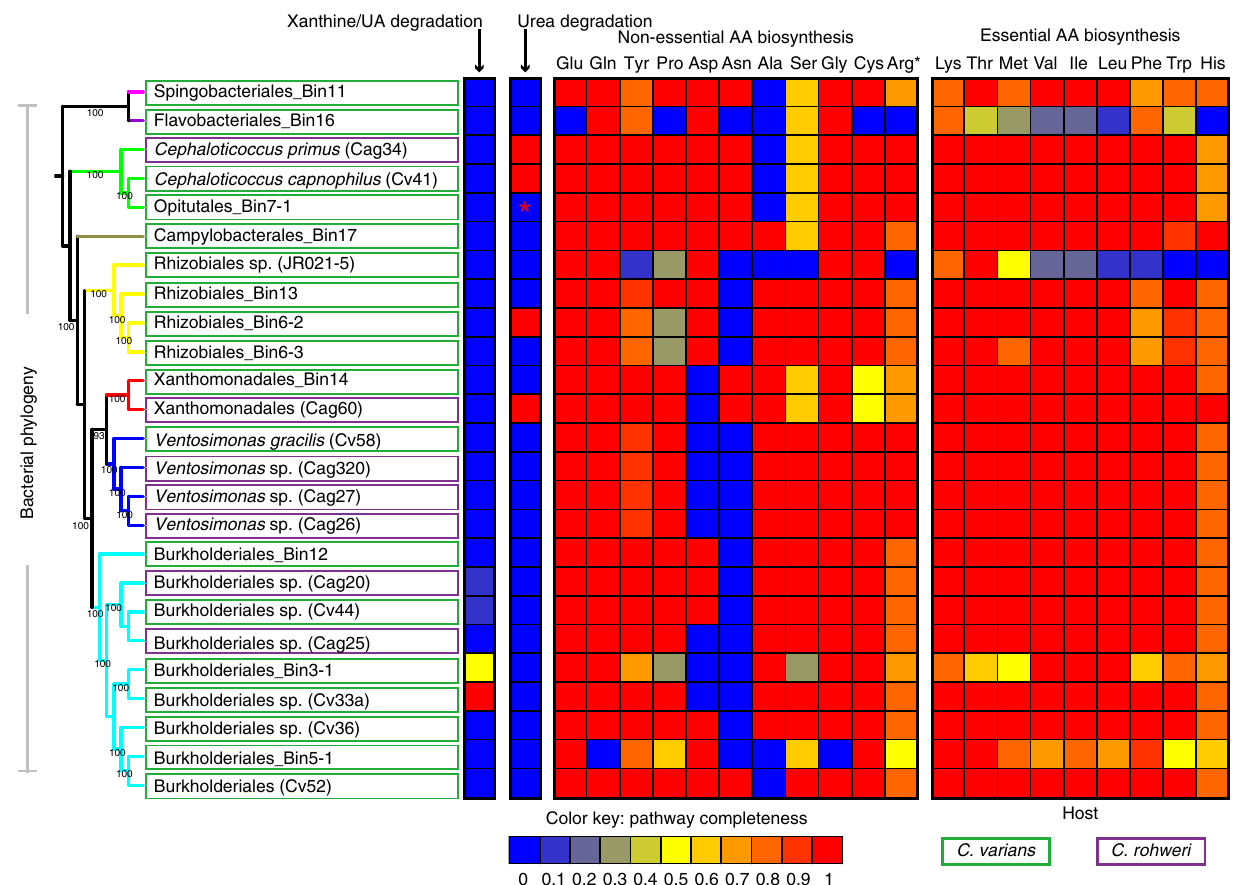
Color key: pathway completeness